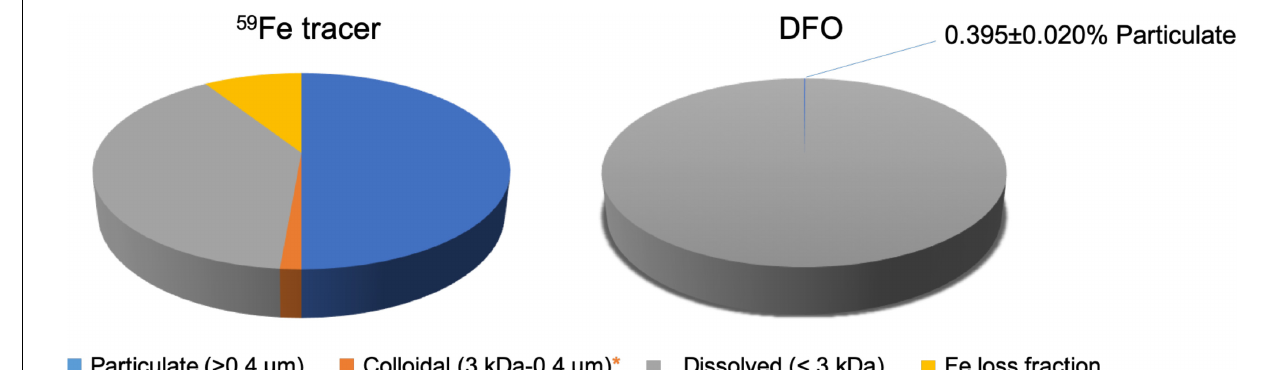
FIGURE 2 | Partitioning of 59 Fe (left) and DFO (right) among suspended particles/aggregates (0.45 µ m), colloids (3 kDa–0.45 µ m), and dissolved phase ( < 3 kDa) after the incubation in northern Gulf of Mexico seawater. Fe loss fraction ( ∼ 10%) is presented here, calculated from the difference between the total added 59 Fe concentration and the sum of particulate-colloidal-dissolved 59 Fe concentrations, which is considered not having participated into the microbial processes. *DFO is undetectable in the colloidal phase and only 1.4% of the total 59 Fe was observed in the colloidal phase.